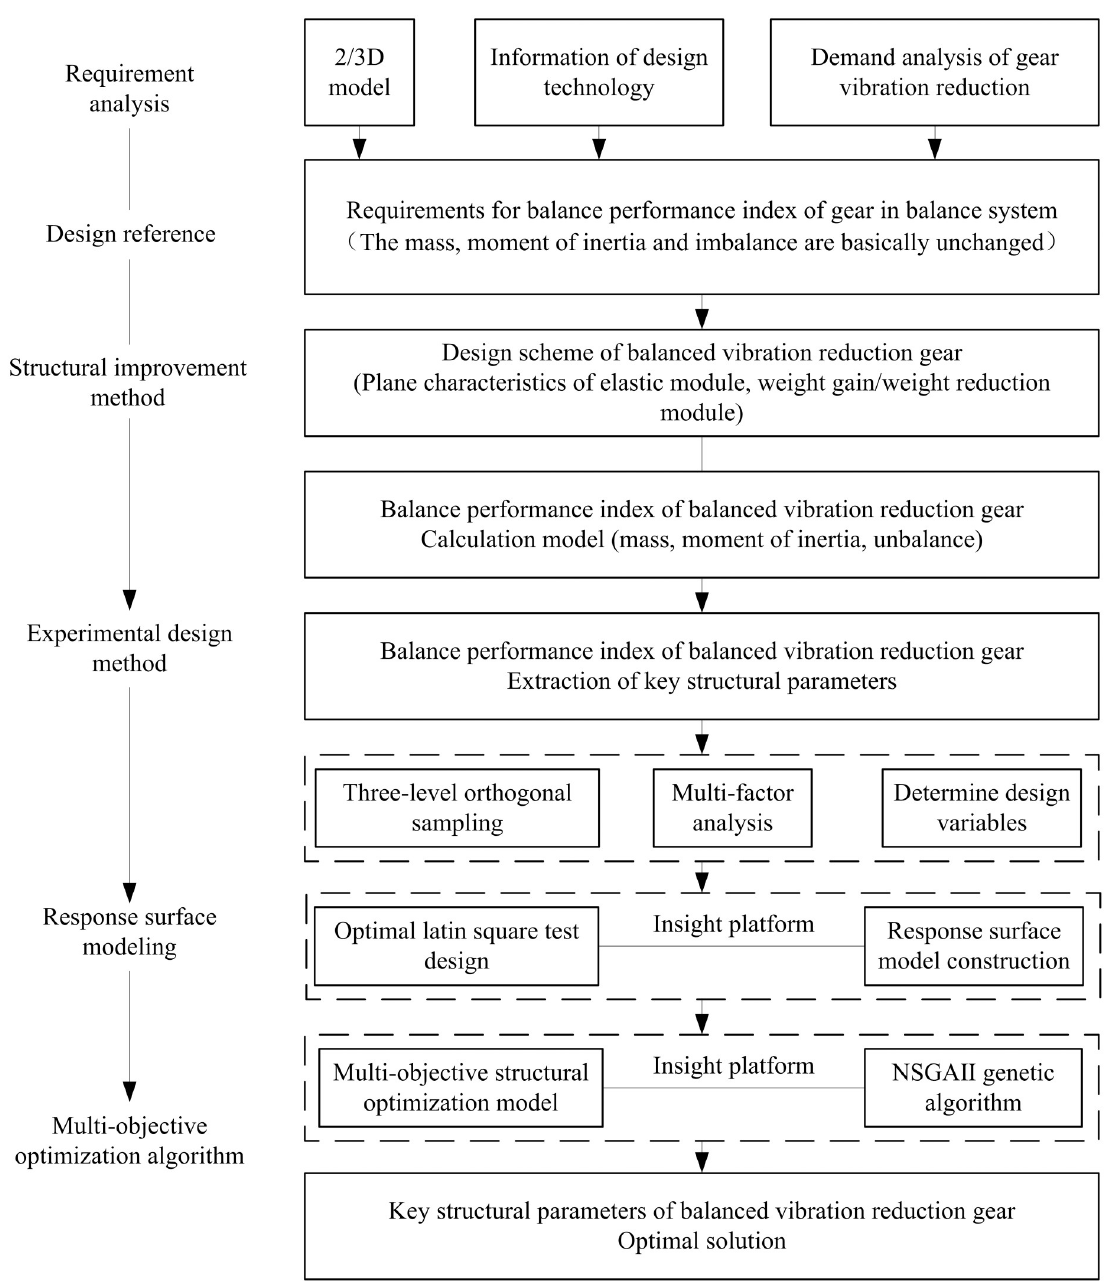
Fig 4. Design process for improving the structure of the balanced vibration balanced